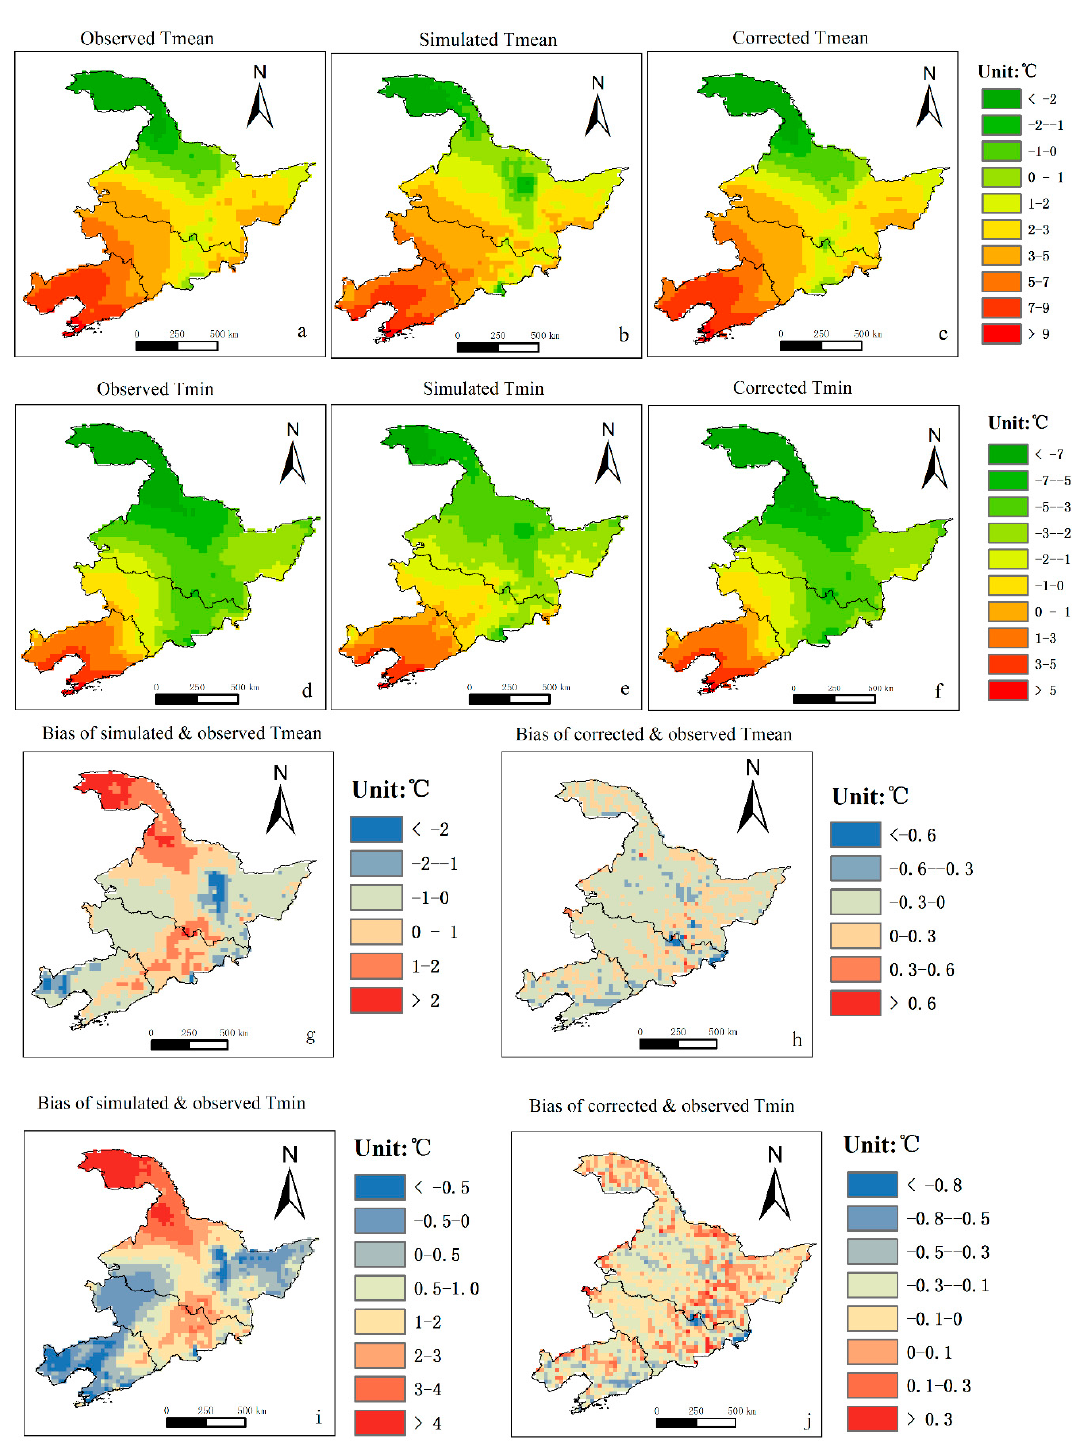
Figure 2. Spatial distributions of T mean and T min for observation, simulation and correction, as well as the bias of simulated and corrected vs. observed T mean and T min during the baseline period: ( a ) observed T mean ; ( b ) simulated T mean ; ( c ) corrected T mean ; ( d ) observed T min ; ( e ) simulated T min ; ( f ) corrected T min ; ( g ) bias of simulated and observed T mean ; ( h ) bias of corrected and observed T mean ; ( i ) bias of simulated and observed T min ; ( j ) bias of corrected and observed T min .